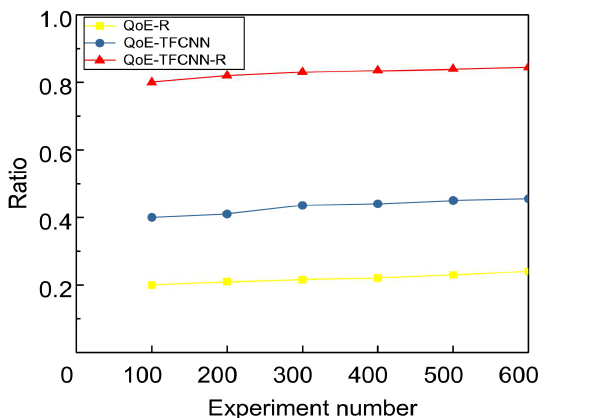
Fig. 7 QoE performance for various transmission rates via h , for different (cid:24)(cid:24)(cid:24) .